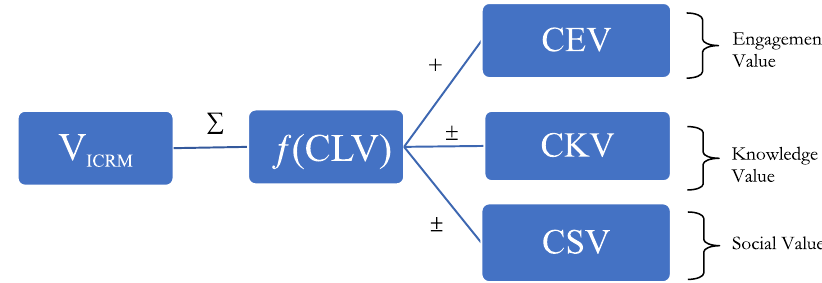
Fig. 1 General structure of the model V ICRM. A diagram that shows the dependency relationships of the components of the V